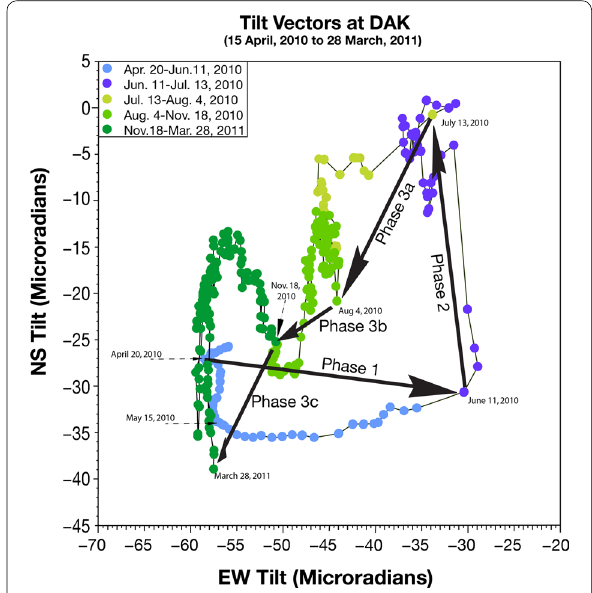
Fig. 8 Tilt vector diagram with time derived from the horizontal components of the tiltmeter located at DAK station. Black heavy vectors correspond to the main episodes of tilt between April 20, 2010, and the end of March 2011, also identified with different